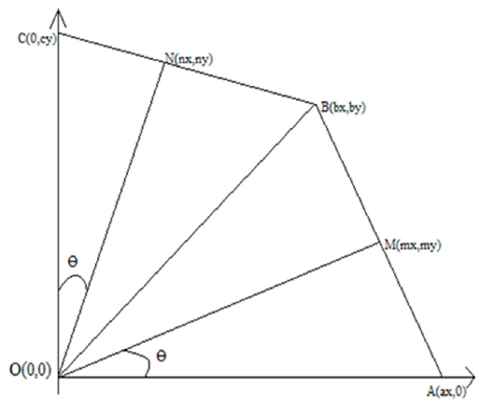
Figure 6. The length of the ON segment is rw 1 and the length of the OM segment is rw 2